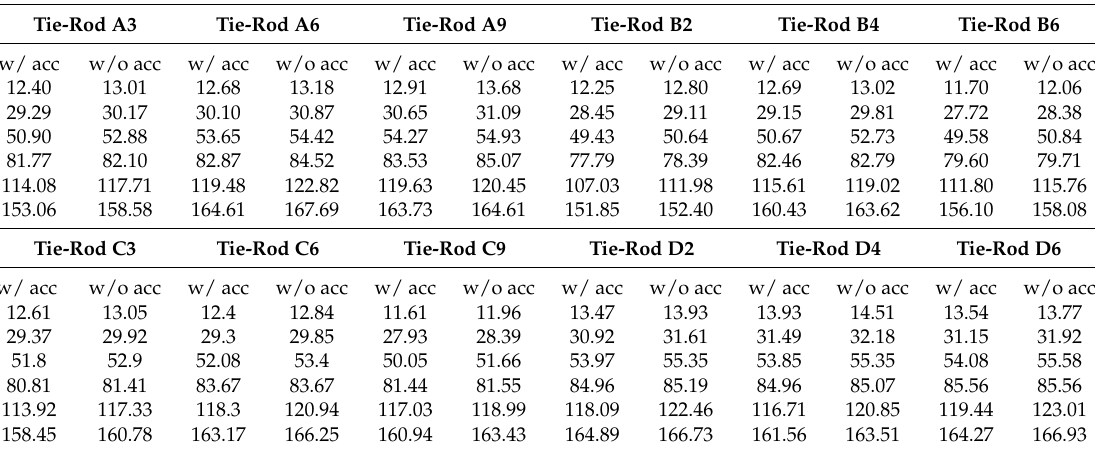
Table 2. Results of testing in the Palazzo Arcivescovile of Pisa: frequency measurements for the lowest vibrational modes of 12 of the 30 tested tie-rods in the cloister. The values shown have been obtained using the professional microphone, with and without accelerometers mounted on the tie-rod with